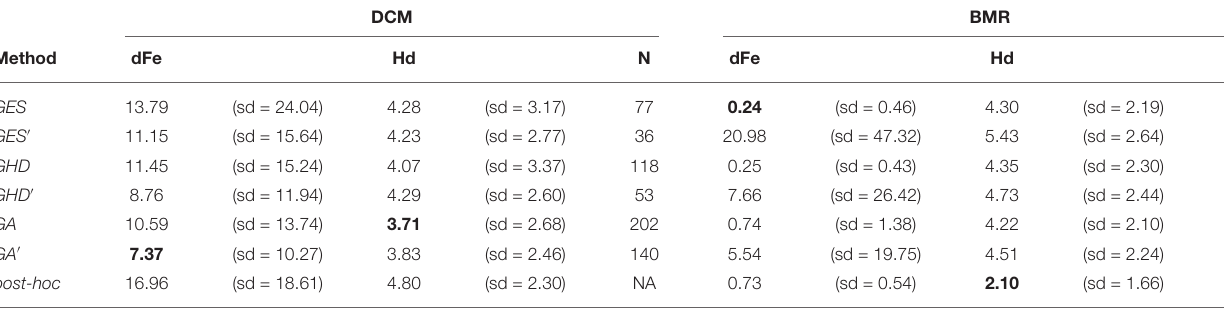
TABLE 3 | Summary of model search results within the model-space estimated by DCM and BMR.